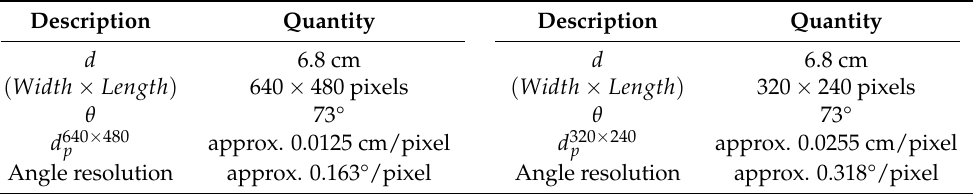
Table 5. Image variables and pixel size equivalency for greater